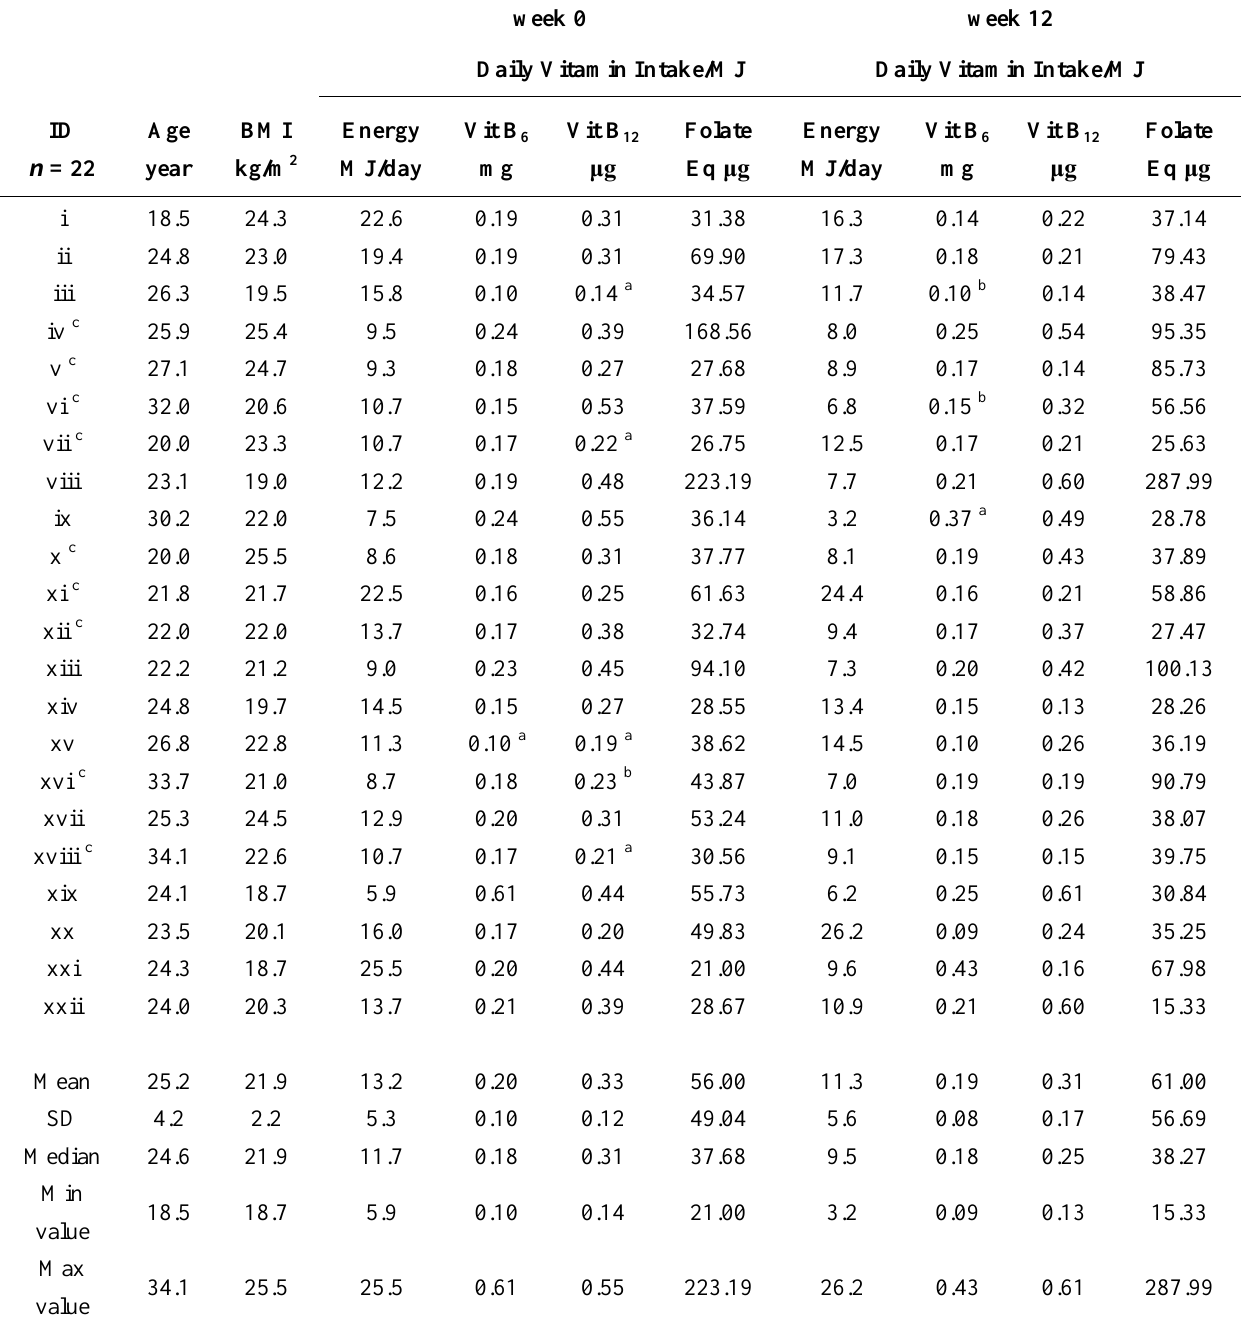
Table 2. Participant age, BMI and intakes energy (MJ/day) and vitamins B vitamin B (μg/MJ) and folate equivalents (μg/MJ) at week 0 and week 12